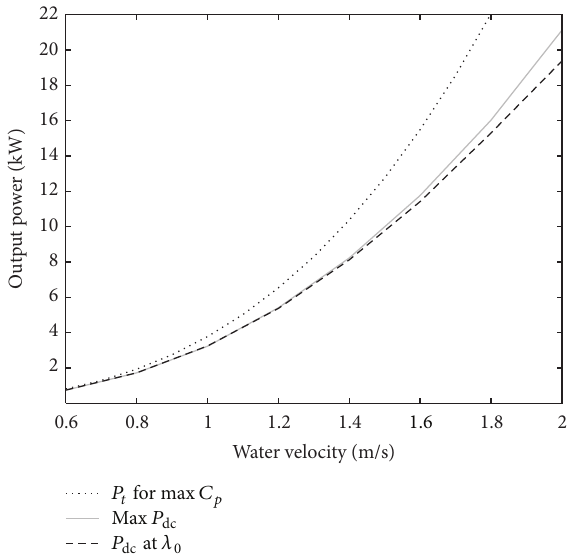
Figure 12: Power capture of the turbine at maximum 𝐶 𝑝 , maximum output power for each velocity, and power output for 𝜆 = 3.5 .